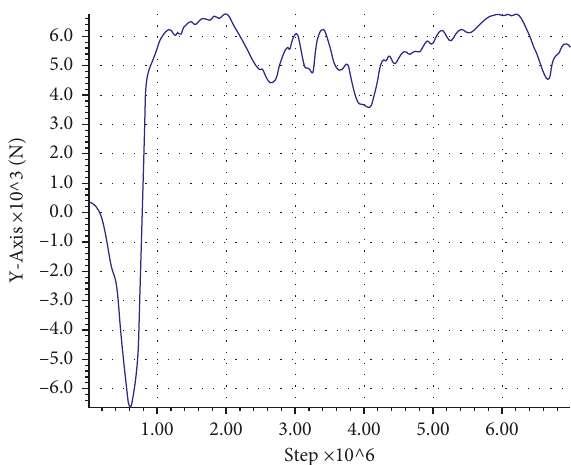
Figure 15: Axial force diagram of the anchor pile No. 2 with a rock- socketed depth of 10 cm.